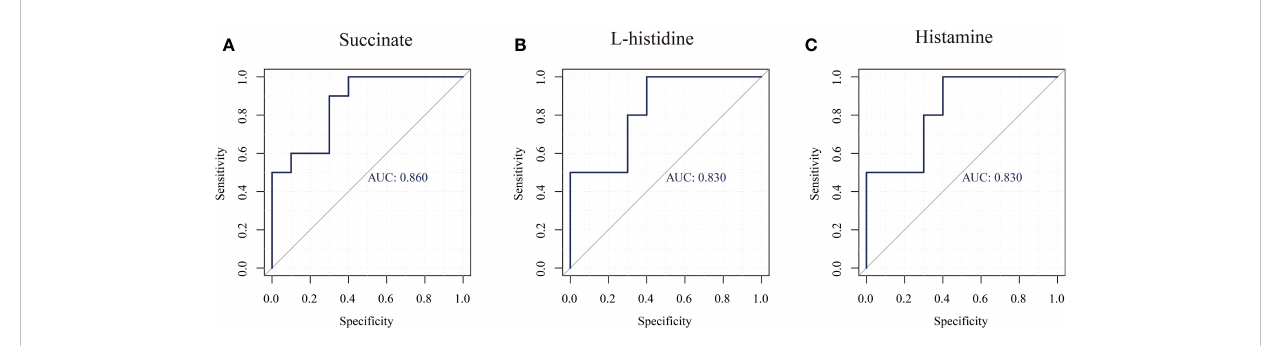
FIGURE 5 ROC curves of three major differential metabolites (Succinate, Histamine, L-histidine). (A) Succinate, (B) Histamine, (C)